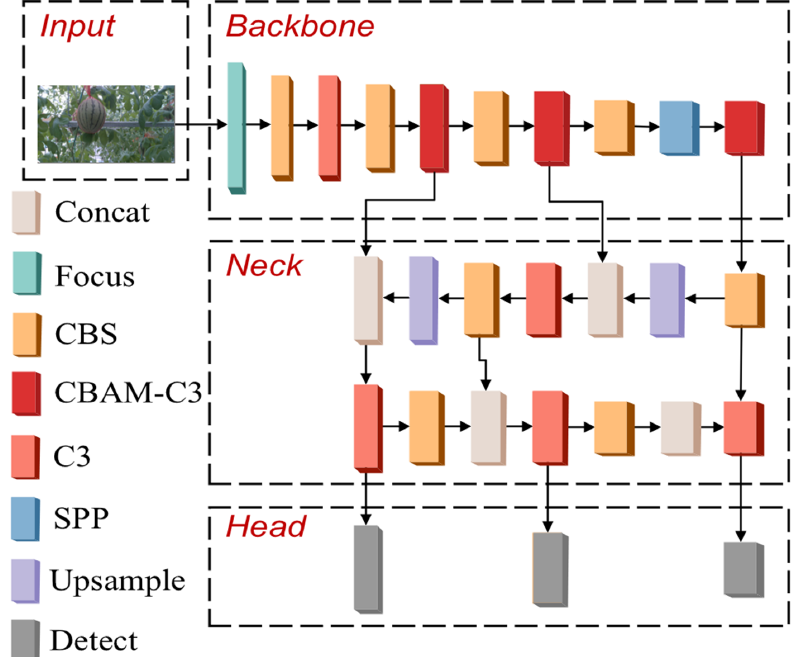
Figure 6. The structure of the improved YOLOv5 detector.